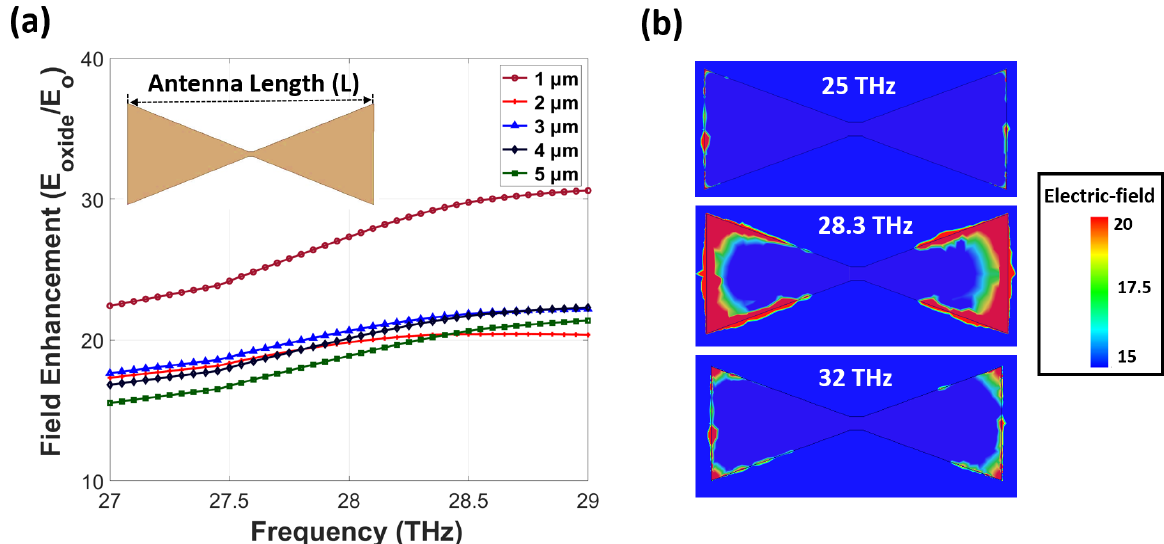
Figure 2. ( a ) The averaged field enhancement at 28.3 THz with variation of the antenna length at the oxide tunnel barrier below antenna edges and ( b ) cross-sectional view of field enhancement on the top of the oxide layer on the x-y plane for different frequencies, 25, 28.3, and 32 THz.